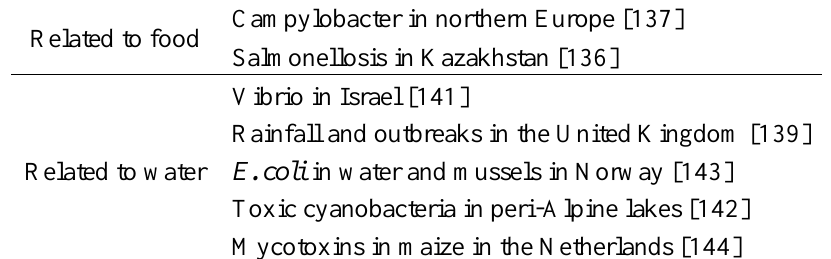
Table 8. Search results (7) of literature on climate change and diseases related to food and